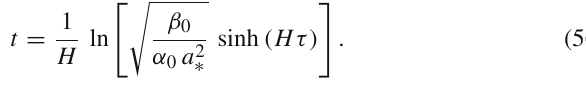
Table 1 The equation of state parameter for a few values of n n − 1 1 2 3 ... w − 5 / 3 − 1 / 3 1 / 3 1